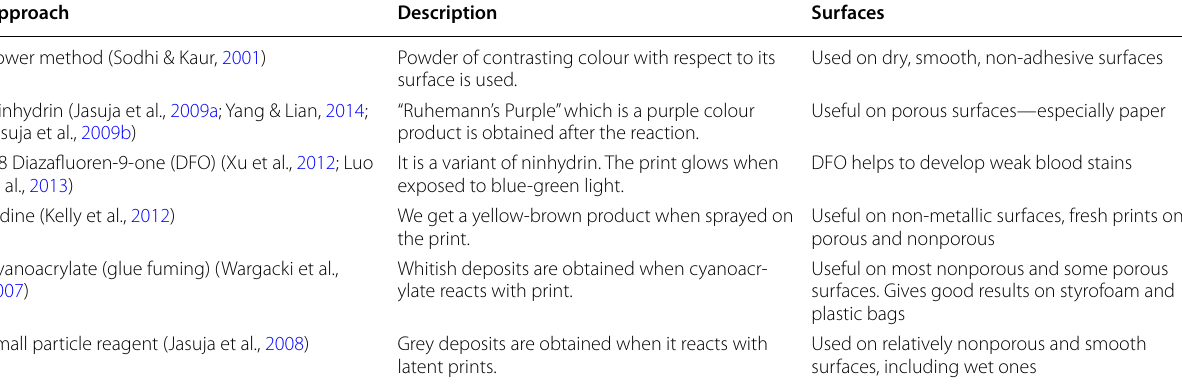
Table 1 Various approaches for fingerprint upliftment